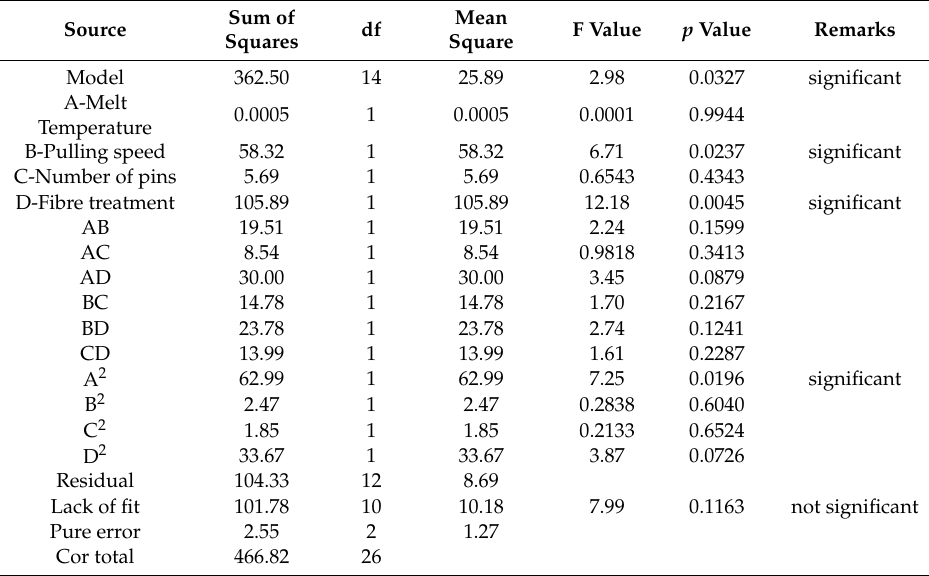
Table 5. ANOVA for interfacial shear strength (IFSS).